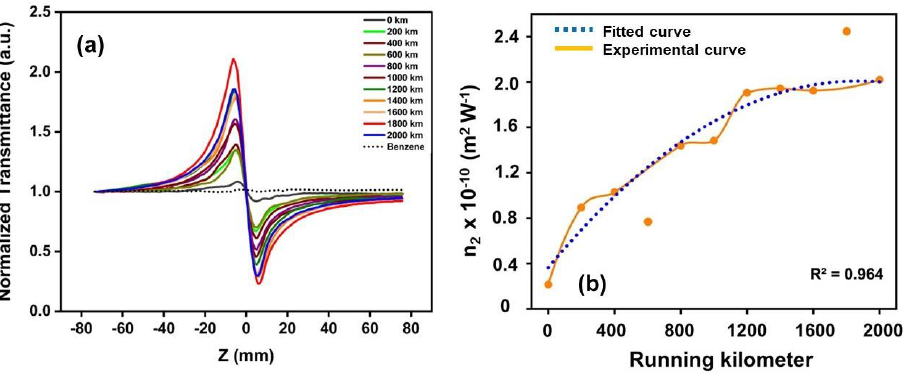
Figure 10. ( a ) The normalized transmittance versus z plot of the samples and the ( b ) nonlinear refractive index variation of the samples with respect to ageing.